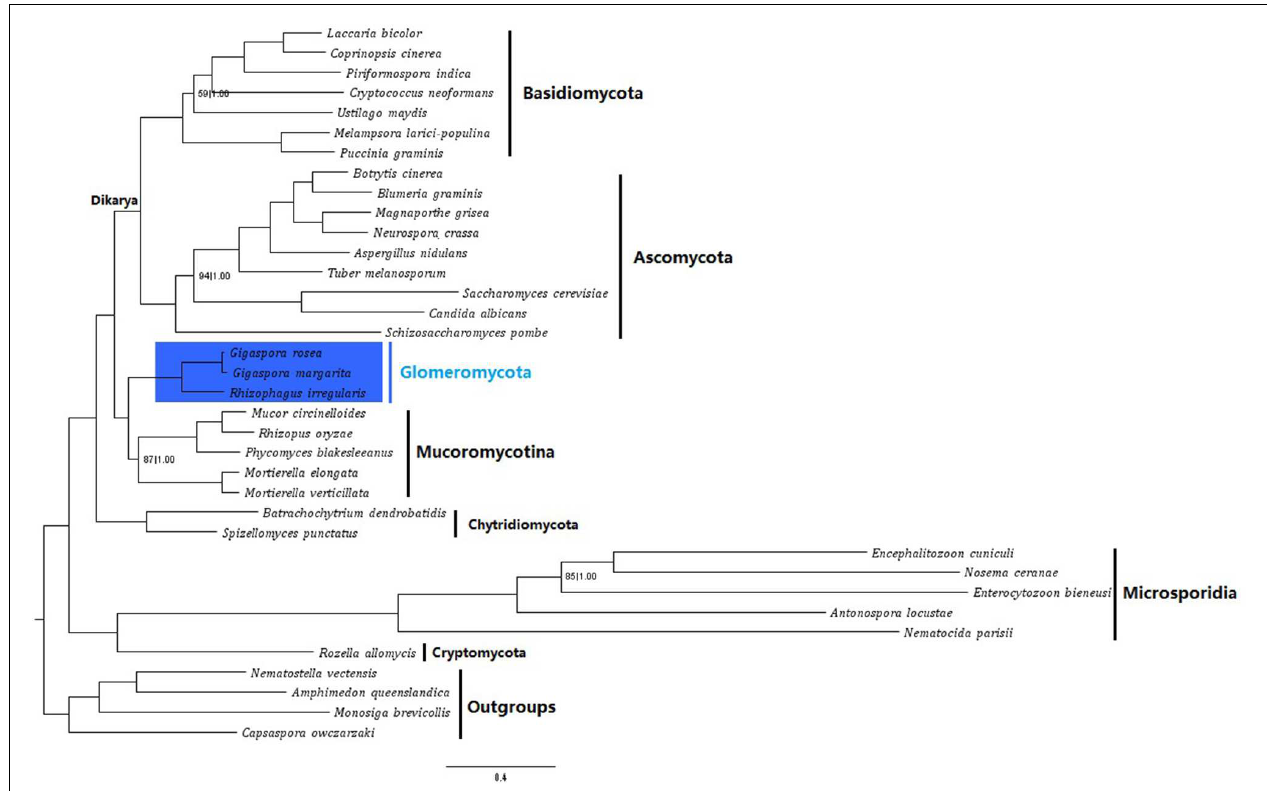
FIGURE 4 | Phylogenetic placement of G. rosea within fungi. Phylogenetic trees were reconstructed on the Gblocks refined supermatrix of 118 orthologous genes, using both Bayesian and Maximum-likelihood (ML) algorithms. Only the Bayesian tree is displayed, as trees inferred by both methods were nearly identical. Statistical support values: Bootstraps (BS) followed by Bayesian posterior probabilities (BPPs) were computed for each node and only the nodes with either BS < 100 or BPP < 1.00 are indicated. The scale bar represents the number of amino acid substitutions per